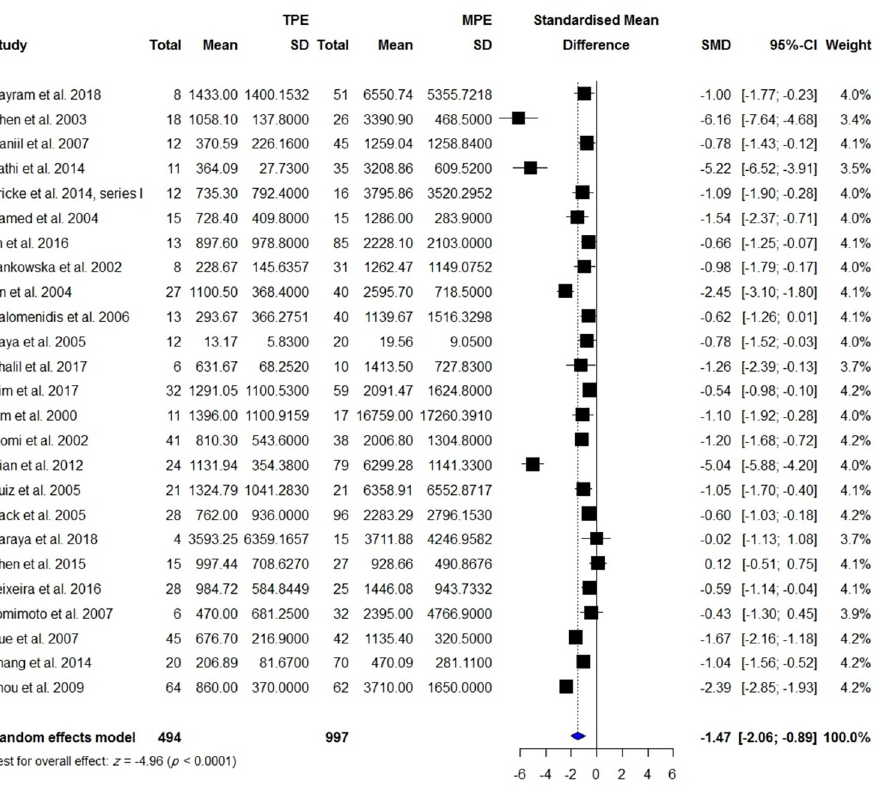
Fig 9. Meta-analysis of blood VEGF levels in patients with TPE vs. patients with MPE.